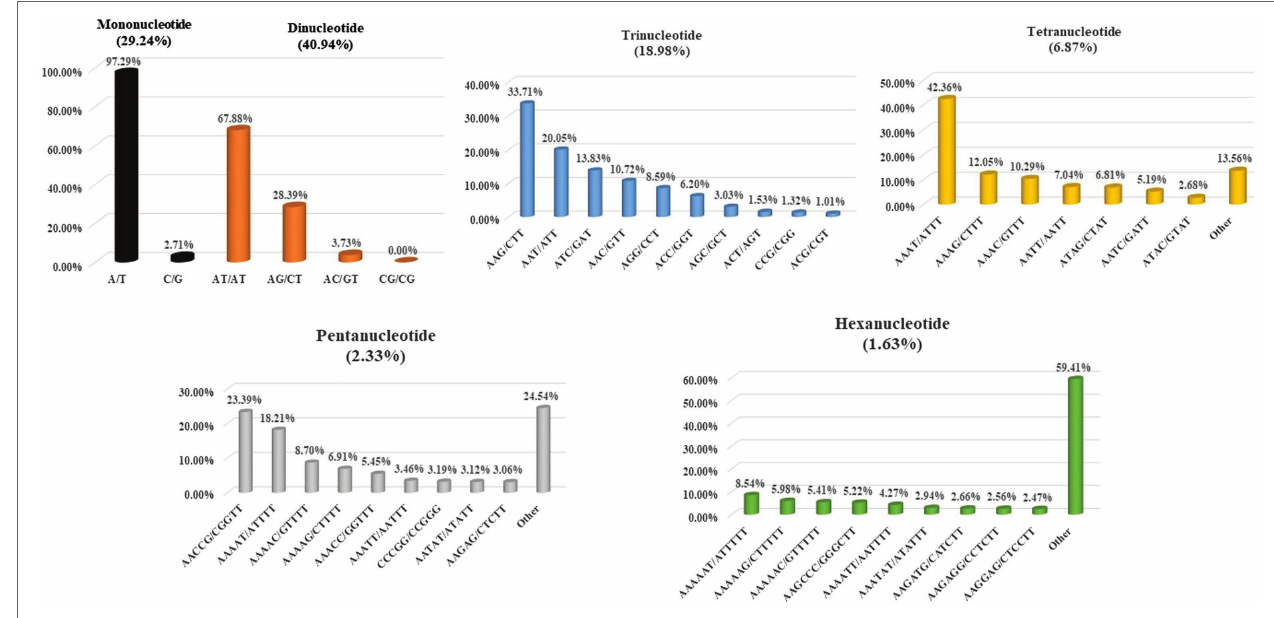
FIGURE 3 | Distribution of the major repeat motifs in cabbage genome.